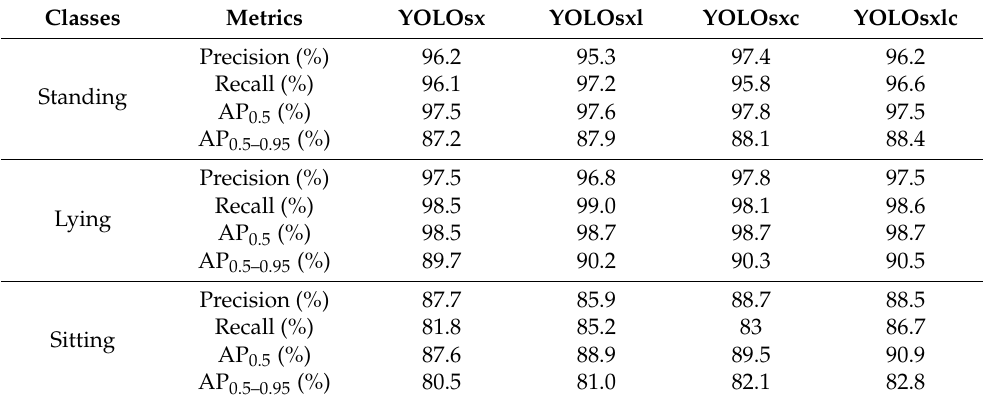
Table 5. Experimental results of copy-paste and label smoothing added to YOLOsx on the test